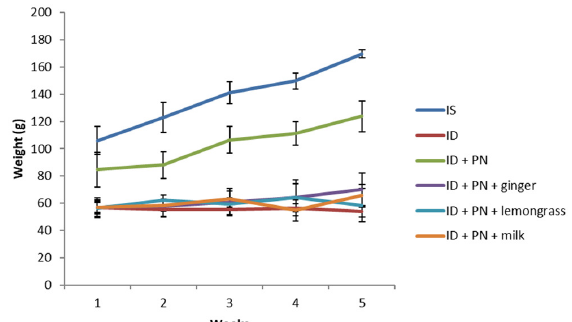
Figure 1. Growth pattern of rats following oral administration of 1000mg/kg body weight infused extracts of P. nigrescens with additives for 28 days Values are means of 3 determinations ± SEM. IS: Iron Sufficient Rats; ID: Iron Deficient Rats; PN: Parquetina